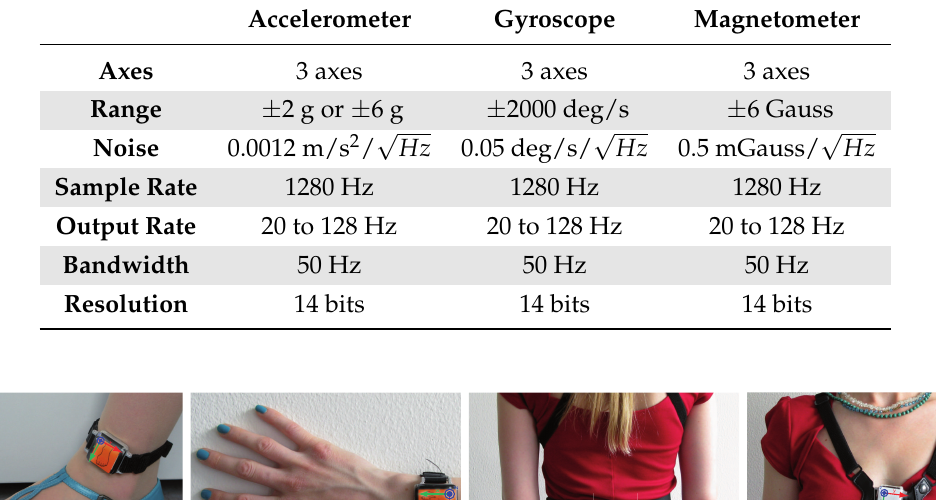
Table 3. Technical specifications of the APDM Opal IMU.